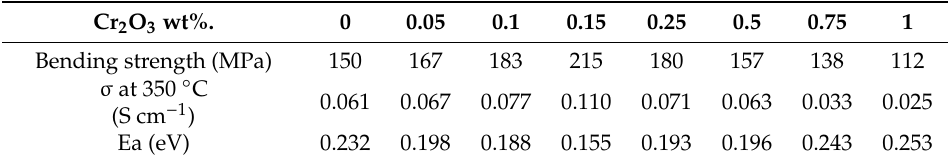
Table 3. Some calculated parameters and measured properties of the sinters with di ff erent amounts of Cr 2 O 3